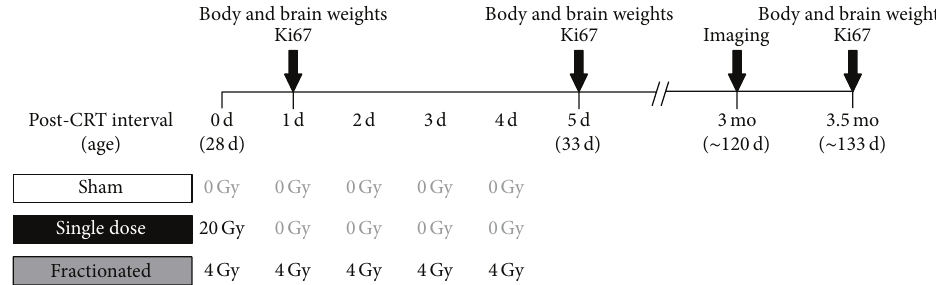
Figure 1: Experiment design and timeline. Note that animals were euthanized at 1d, 5 d, and 3.5 mo, making this a between-group design.